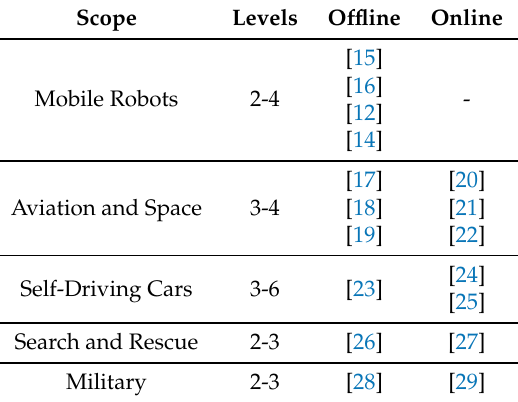
Table 1. Sliding Autonomy in different